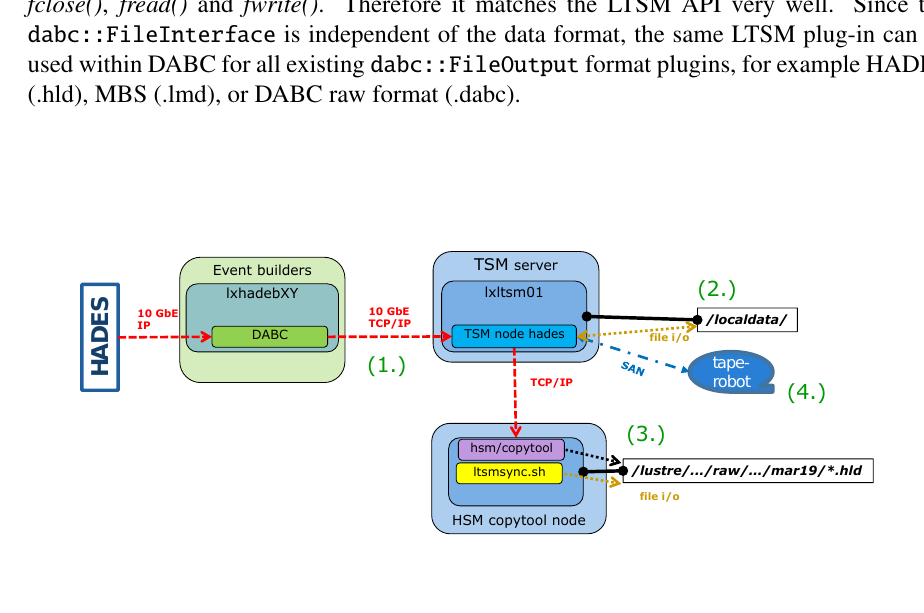
Figure 3. The functionality of the DABC LTSM plug-in as used for HADES in March 2019. The event builders can open and write hld files directly into the archive and to Lustre via a 10 GbE socket connection. See main text for